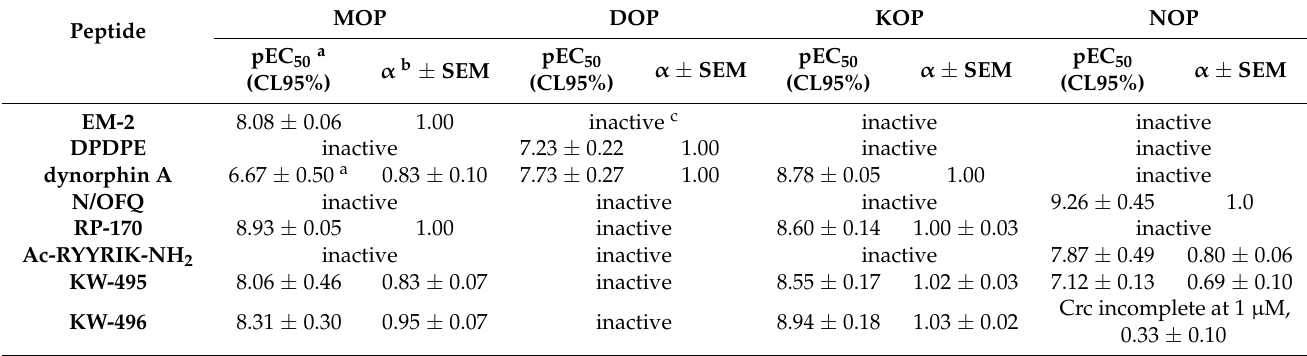
Crc incomplete at 1 µM, 0.33 ± 8.94 ± 0.18 1.03 ± 0.02 0.10 Table 2. Effects of the hybrids and of reference compounds at human recombinant opioid receptors a Agonist potency values (pEC 50 ). b Efficacy values ( α ). c Inactive means that the compound was coupled with calcium signaling via chimeric G proteins. EM-2, DPDPE, dynorphin A and N/OFQ were inactive up to 1 µM. p < 0.05 according to one-way ANOVA followed by the Dunnett test for used as reference agonists for calculating intrinsic activity at MOP, DOP, KOP and NOP, respectively. multiple comparisons. MOP DOP KOP NOP